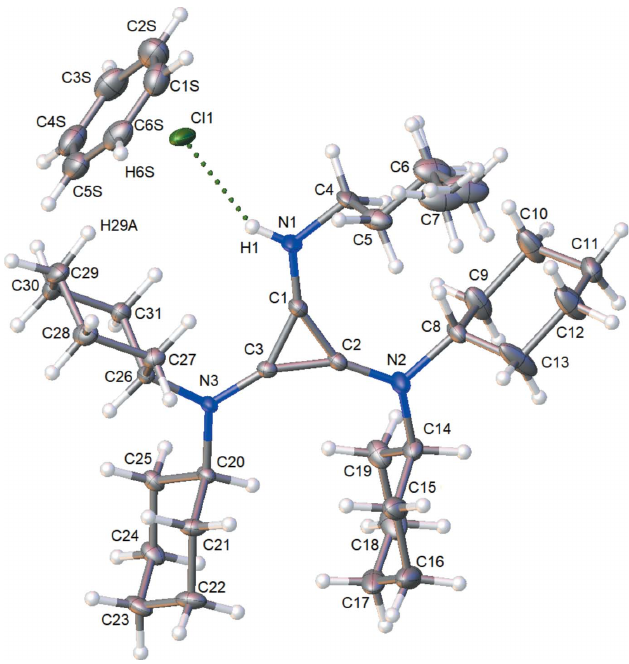
Figure 2 Displacement ellipsoid plot of the asymmetric unit of [ 1 H]Cl (cid:2) C 6 H 6 with ellipsoids set at the 50% probability level. Hydrogen atoms shown as small